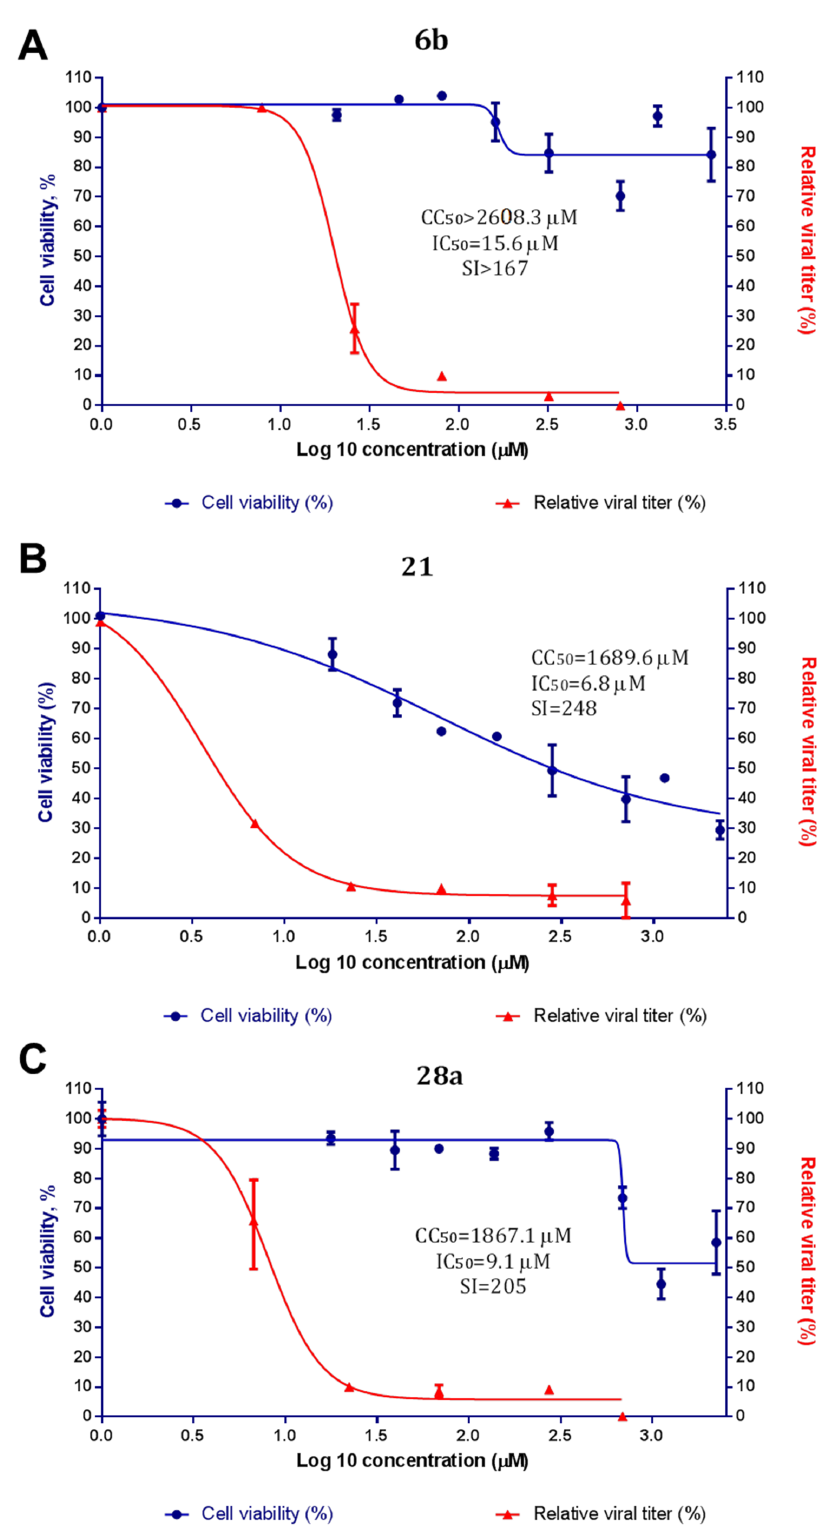
Figure 2. Cytotoxicity and anticoxsackievirus B3 activity of 6b ( A ), 21 ( B ), and 28a ( C ): logistic curves for cell viability (MTT assay) and relative viral titer (virus yield reduction